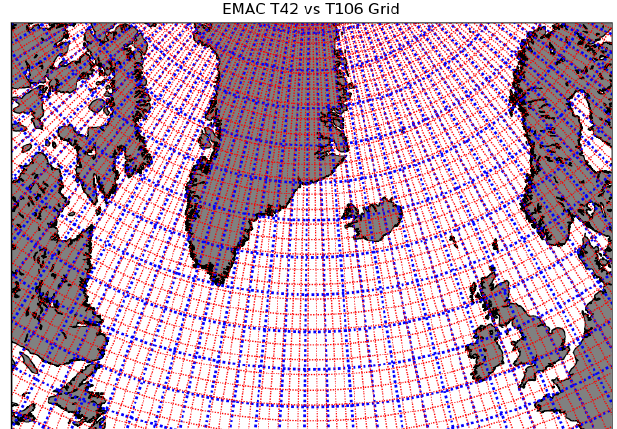
Figure 3. The EMAC standard and sensitivity simulations em- ployed Eulerian grids with 106 (red) and 42 (blue) spectral coef- ficients. The T106 (T42) grid corresponds to a horizontal resolution of 125km (310km) at the Equator. Due to the grid convergence, the zonal grid spacing is reduced towards the poles and amounts to ∼ 40km ( ∼ 110km) at 70 ◦